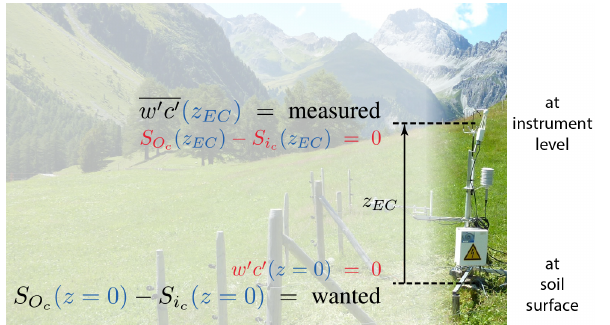
Figure 2. Under the assumption of negligible horizontal and verti- cal flux divergence, the covariance w (cid:48) c (cid:48) measured at the instrument − S i height z ec is a direct measure of the net flux S o at the soil sur- c c face. This simplified assumption can be made for chemically inert components c that do not have any sources and sinks above the soil − S i surface, so that the term S o is zero at the instrument height c c z ec . Correspondingly, there is no turbulent flux at the soil surface and inside the soil volume; hence w (cid:48) c (cid:48) is zero at the soil surface and